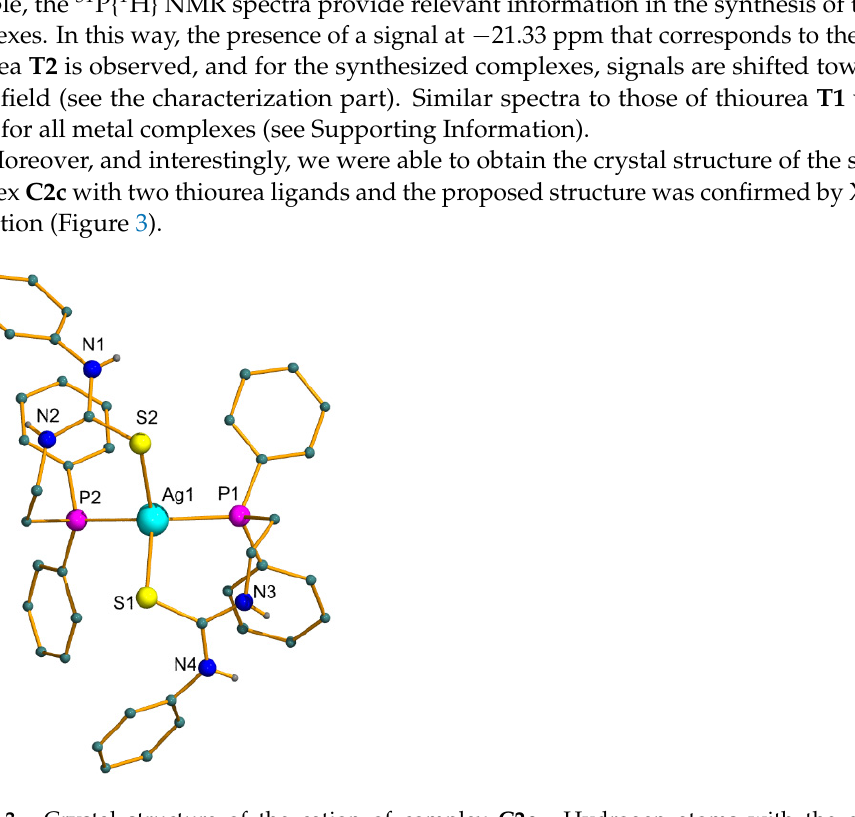
Figure 3. Crystal structure of the cation of complex C2c . Hydrogen atoms with the exception of thiourea NH have been omitted for clarity. Selected bond lengths (Å) and angles (°): Ag1-P1 2.4198(11), Ag1-P2 2.4270(13), Ag1-S1 2.6725(8), Ag1-S2 2.7028(9), S1-C41 1.694(2), S2-C42 1.714(2); P1-Ag1-P2 137.81(3), P1-Ag1-S1 101.74(3), P2-Ag1-S1 105.08(3), P1-Ag1-S2 101.87(4), P2-Ag1-S2 102.96(3), S1-Ag1-S2 103.18(3).